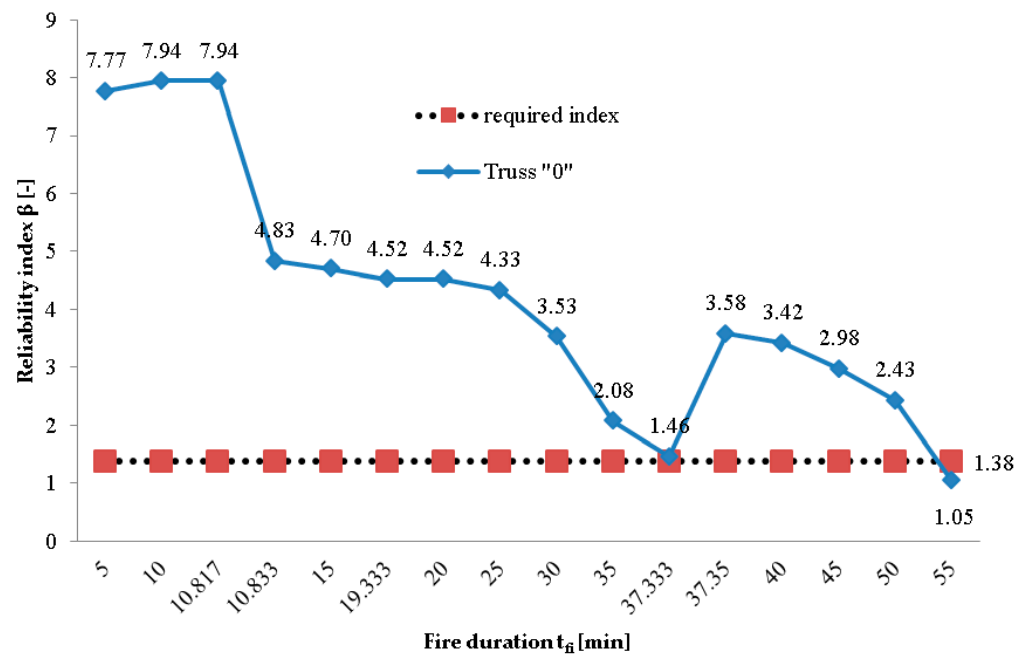
Figure 10. Change in the reliability index of truss “0”.